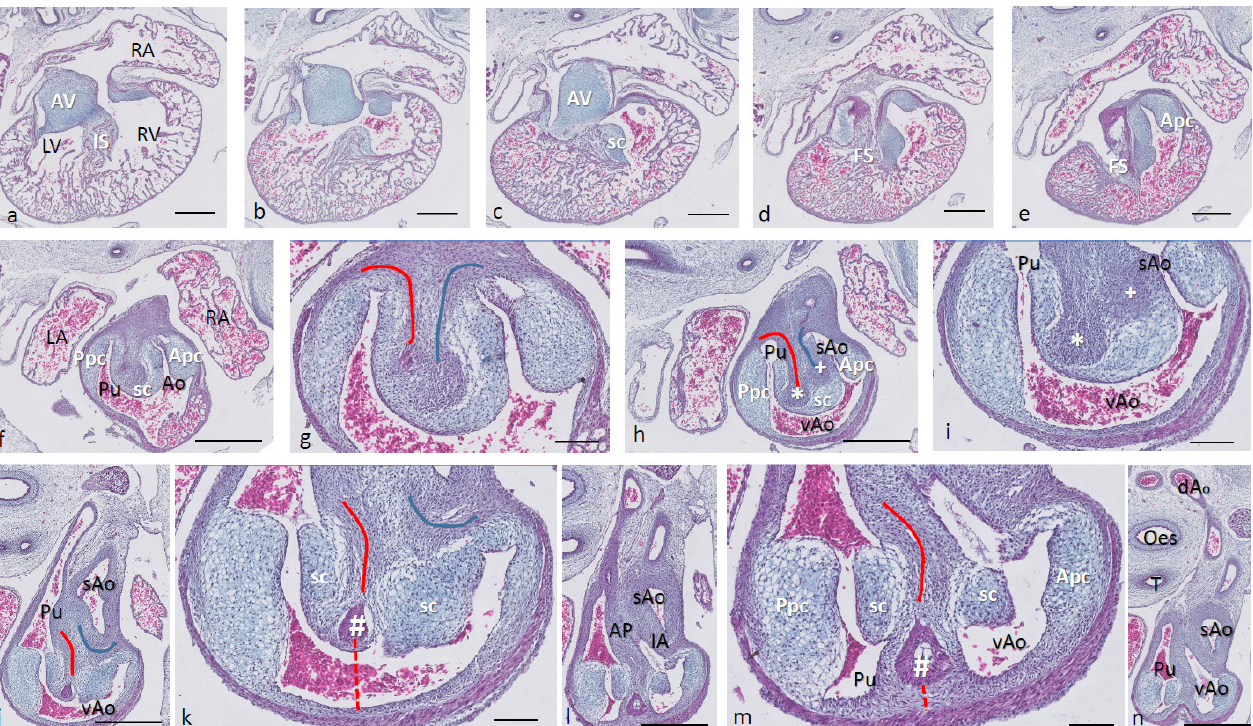
Figure 1. Ferguson stage 17. HE Alcian blue-stained serially sectioned embryo. Figure ( a – n ) from AV canal to pharyngeal arch arteries. Generally, the endocardial cushions stand out because of the Alcian blue staining. Figure ( a ), myocardium is spongious with a thin compact outer layer. The inlet septum is the most conspicuous part of the interventricular septum located between the left- and right-sided parts of the undivided common ventricle. Figure ( b , c ), the outflow tract septal cushion becomes visible. Figure ( d , e ), the folding septum only becomes clear more distally. Figure ( f ), pulmonary and aortic parietal OFT cushions become apparent, flanking the pulmonary channel and the yet common aortic channel. Figure ( g ), magnified Figure ( f , in the large centrally located septal cushion, two streams of condensed mesenchyme, on the pulmonary side (in red) and the aortic side (in blue). The septal cushion becomes subdivided over the main arterial channels. Figure ( h , i ), both streams end separately in a bulbous structure as the basis for the AP septum (*) and IA septum (+). Figure ( j ), magnified in Figure ( k ), the AP stream meets the ventral myocardial spur (#). Figure ( l ), magnified in ( m ), the myocardial spur is part of the ventral myocardium indicated by the red dotted line. At this level, the AP septum is completed. Figure ( n ), pharyngeal arch arteries are separated, and the connection to the dorsal aorta is present. Key to the symbols # ventral myocardium, part of AP septum; * (presumably) left-sided neural crest cells, part of AP septum; + (presumably) right-sided neural crest, part of IA septum; Δ dorsal myocardium, part of AP septum. Magnification Figure ( a – e , f , h , j , l , n ), bar 500 µm; ( g , i , k , m ), 200 µm.